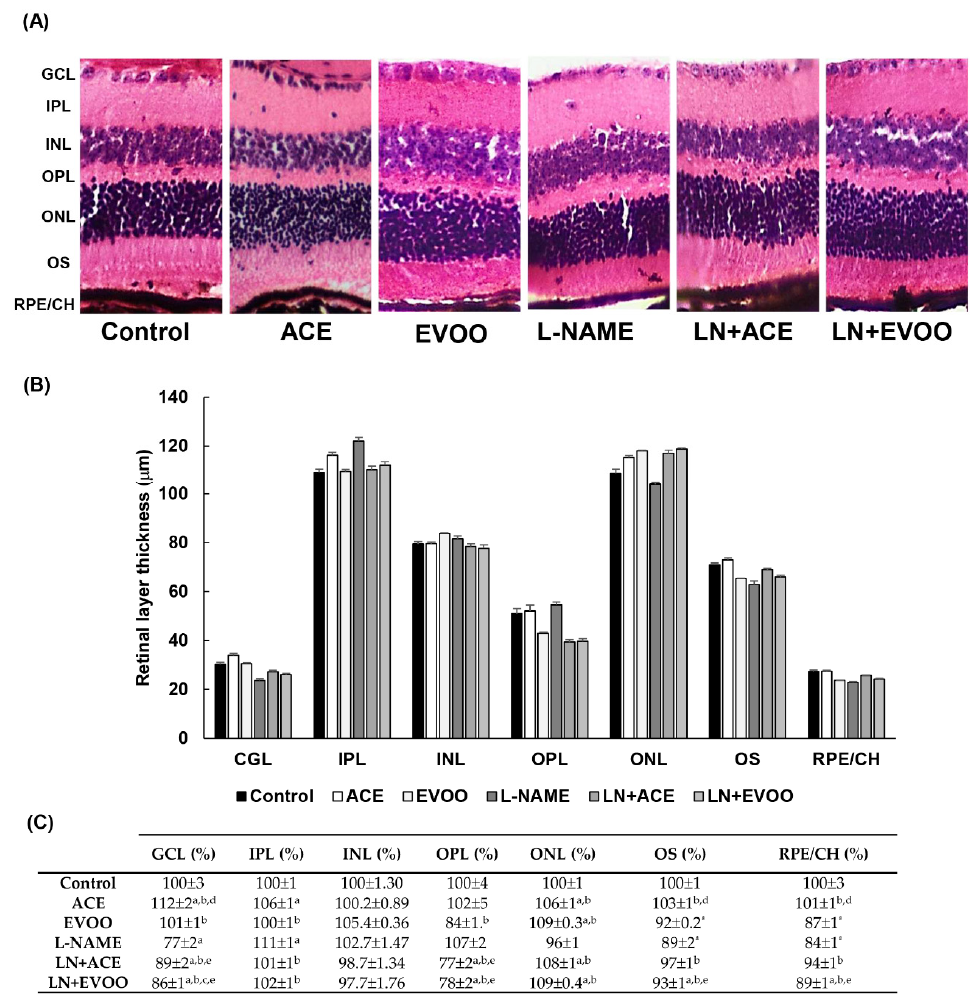
Figure 2. Histomorphometric analyses of retina slides. ( A ) Representative images of hematoxylin / eosin staining; ( B ) retinal layer thickness; and ( C ) percentages of thickness relative to that in the control group. Magnification: 10 × . Values are expressed as mean ± SEM of seven animals per group: a p < 0.05 vs. control; b p < 0.05 vs. L-NAME; c p < 0.05 vs. EVOO; d p < 0.05 vs. LN + EVOO; e p < 0.05 vs. ACE. GCL: ganglion cell layer; IPL, inner plexiform layer; INL, inner nuclear layer; OPL, outer plexiform layer; ONL, outer nuclear layer; OS, outer segments; RPE / CH, retinal pigmentary epithelium /